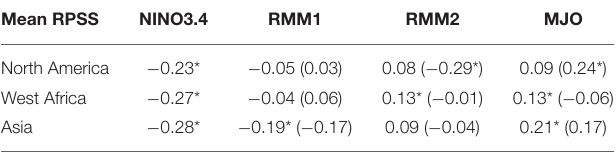
Scores in brackets correspond to correlations for starts during La Niña exclusively, and those significant at 95% level of significance using Monte Carlo simulations are indicated with a star.